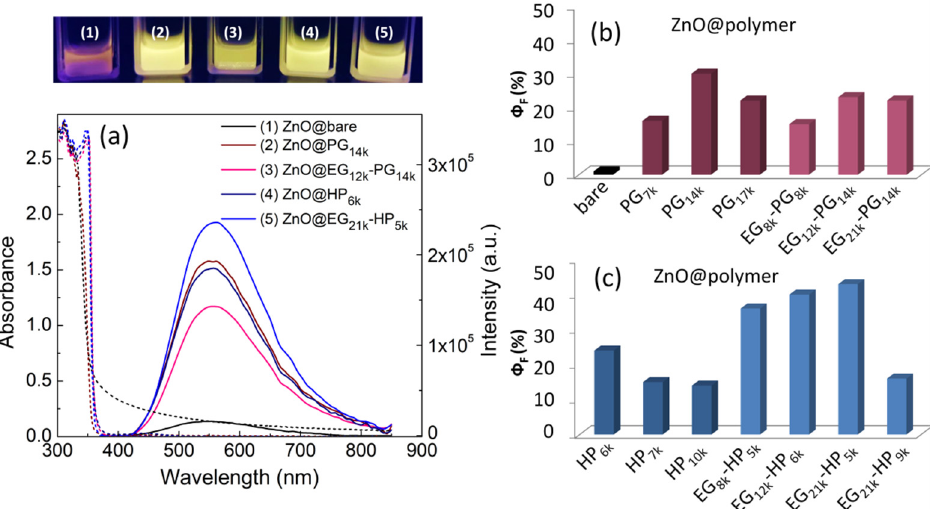
Figure 2. ( a ) Absorbance (dashed lines) and emission fluorescence ( λ exc. = 365 nm) (solid lines) bands from ethanol solutions of ZnO QDs with/without coating as specified in the legend, after 24 h of their synthesis; the insert at the top shows photos of these ZnO QDs samples under UV light (365 nm). ( b ) Φ F (%) for ZnO QDs synthesized without polymer and in the presence of PG x homopolymers and EG y -PG x block copolymers of different molecular weights. ( c ) Φ F (%) for ZnO QDs synthesized in the presence of HP x homopolymers and EG y -HP x block copolymers of different molecular weights.